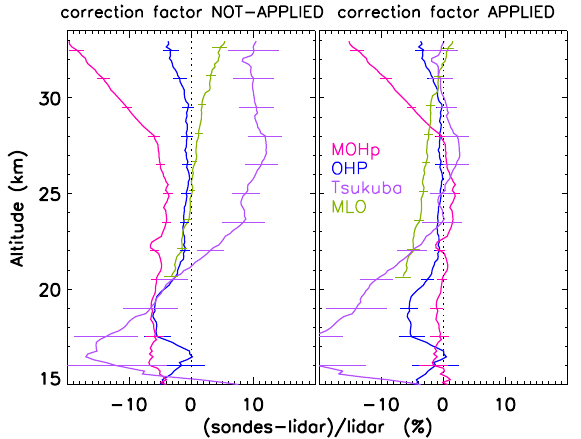
Fig. 3. The average bias of sonde measurements, without (left panel) and with (right panel) multiplying the profiles by the correc- tion factor, obtained for the comparison with lidar at MOHp, OHP, Tsukuba and MLO. The dotted vertical line represents 0%, and the error bars correspond to twice the standard